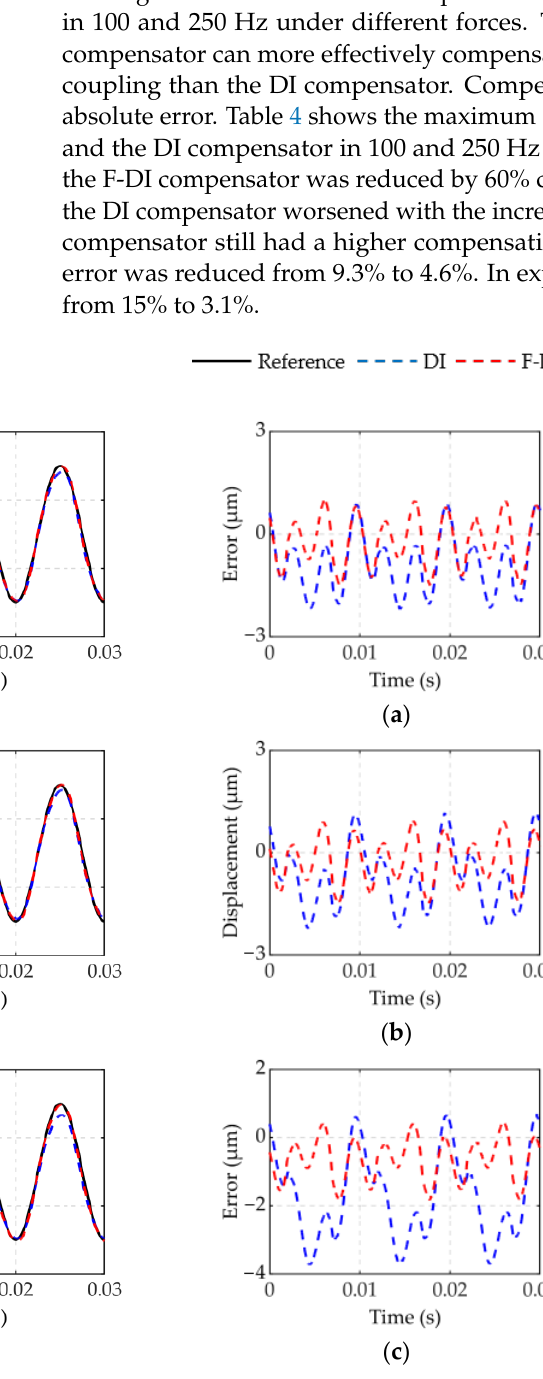
Figure 13. Feedforward experimental in 100 Hz at different forces: ( a ) spring 2; ( b ) spring 3; ( c ) spring 4.